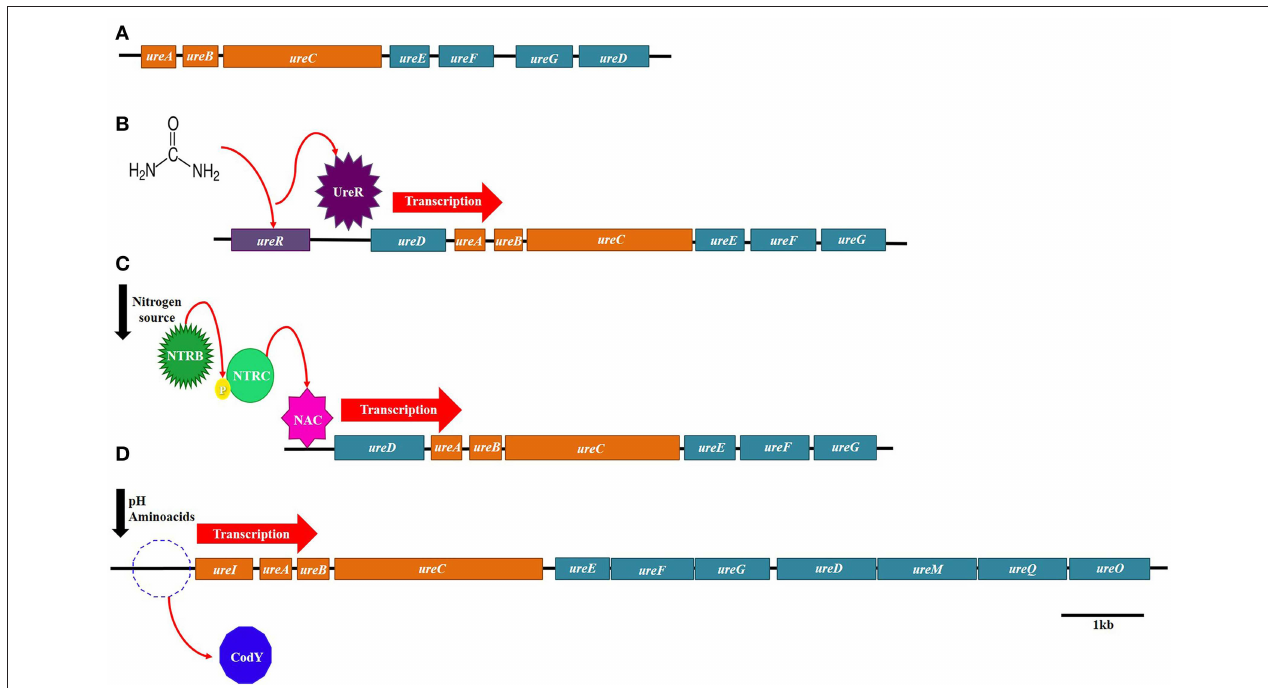
FIGURE 5 | Regulatory mechanisms of urease. (A) Urease constitutive system in Sporosarcina pasteurii . (B) Urease System induced by urea in Proteus mirabilis . (C) Urease system induced by nitrogen availability in Klebsiella aerogenes . (D) Urease system induced by pH in Streptococcus salivarius